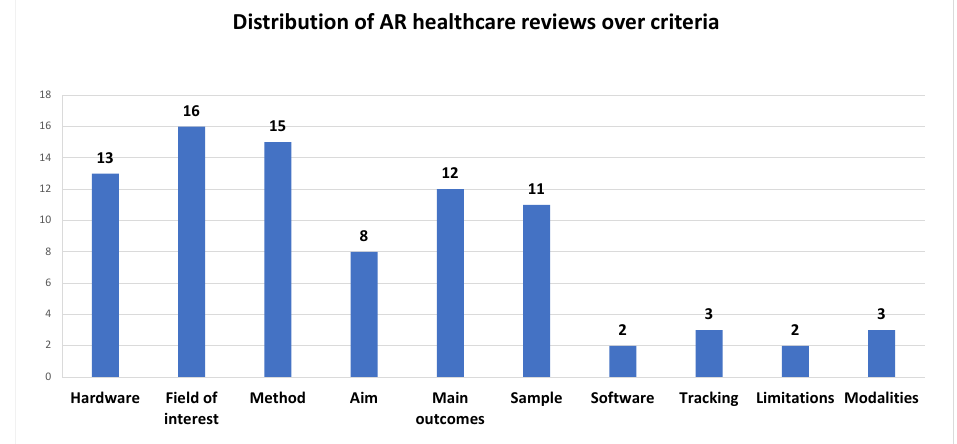
Figure 5. Distribution of AR healthcare reviews over criteria (min: 2–max: